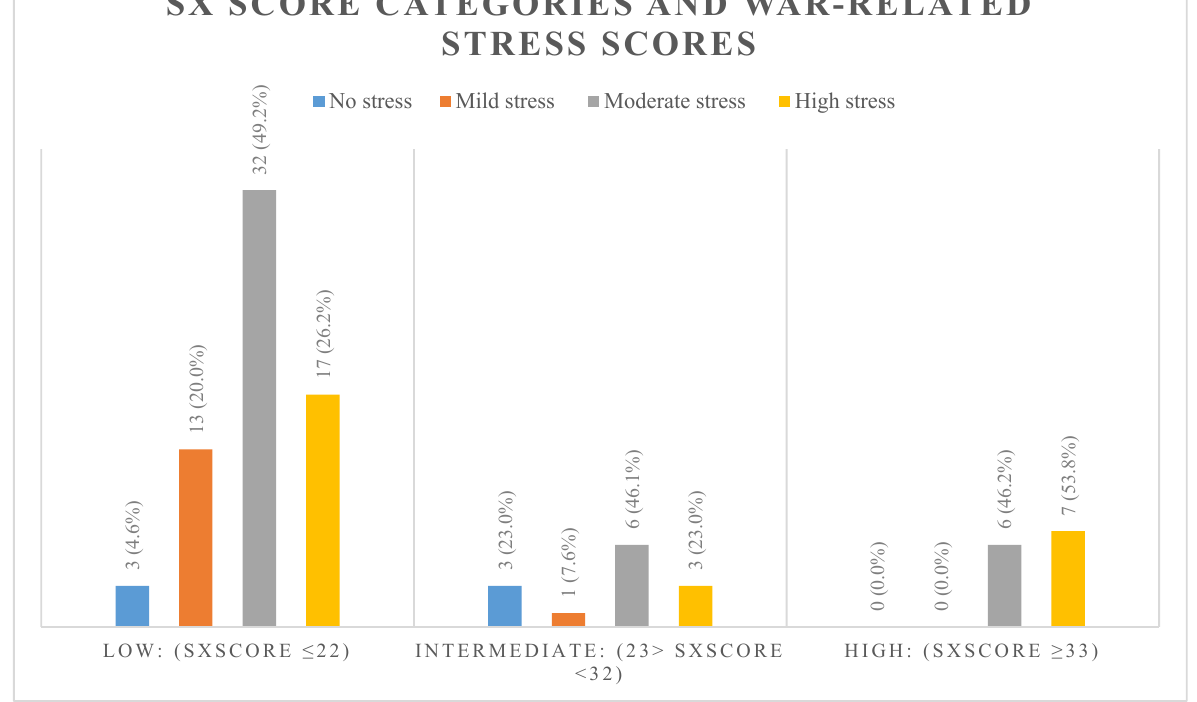
Figure 1. Frequency of war-related stress degrees within the different SX score categories. Table 3. Regression model for predictors of SX